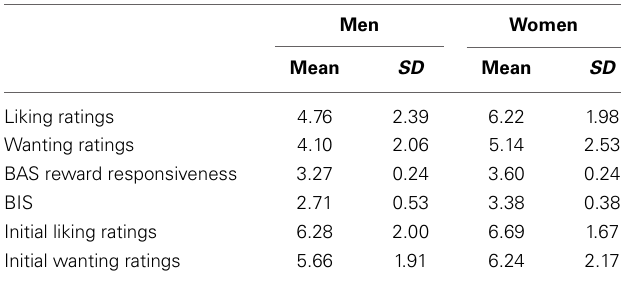
Table 2 | Mean values and standard deviations ( SD ) for questionnaire scales and